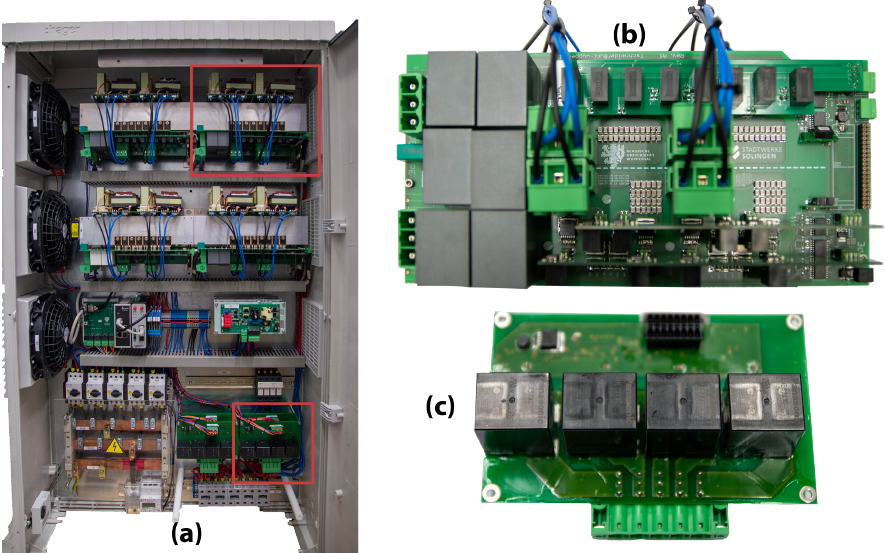
Figure 4. ( a ) Remote Supply, ( b ) Converter Module, ( c ) Switching Matrix